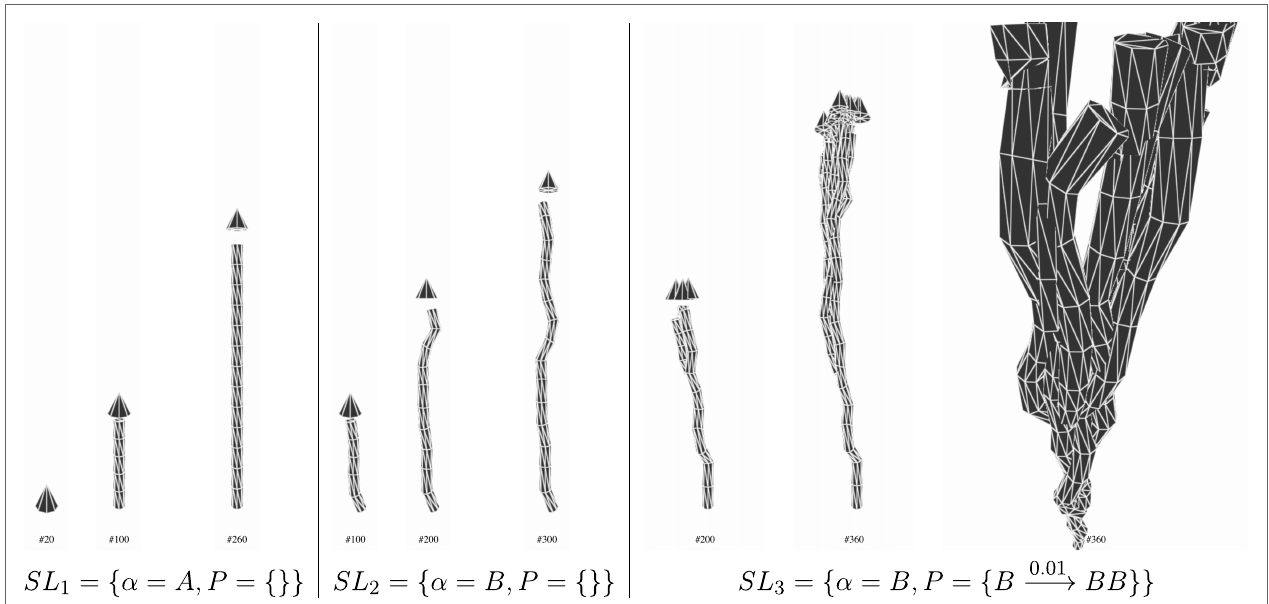
FigUre 3 | Three increasingly complex swarm grammars. The counters beneath the screenshots indicate the progression of the respective simulation. The rewrite systems SL express which agent configurations were deployed an whether and how they reproduced. The right-hand side image shows a close-up of the branched structure from SL 3